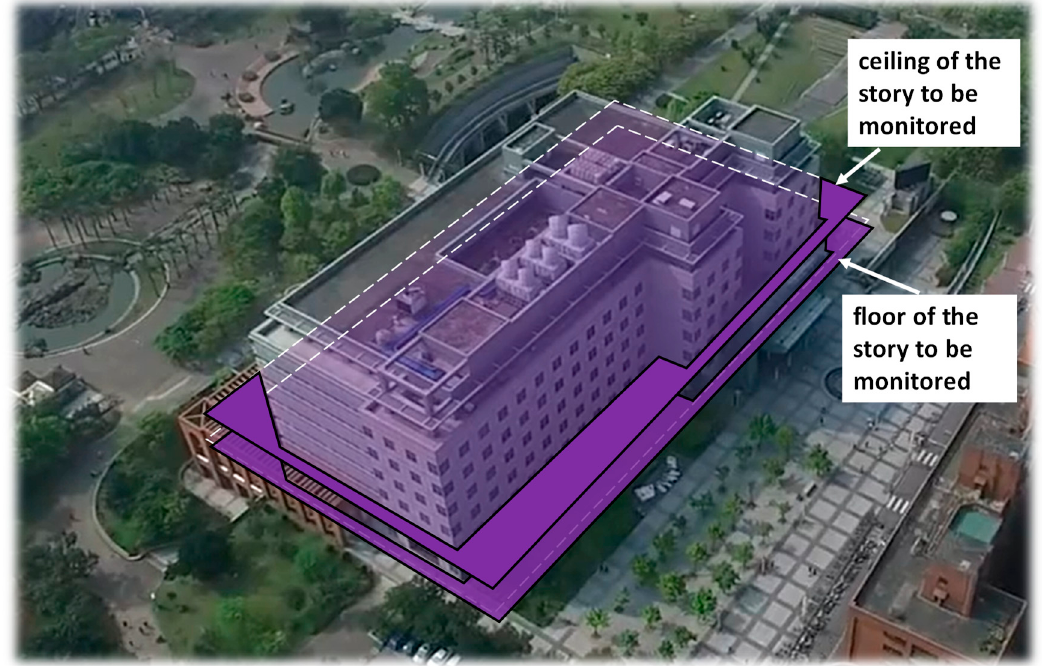
Figure 1. The ceiling and floor of a certain story of a building.